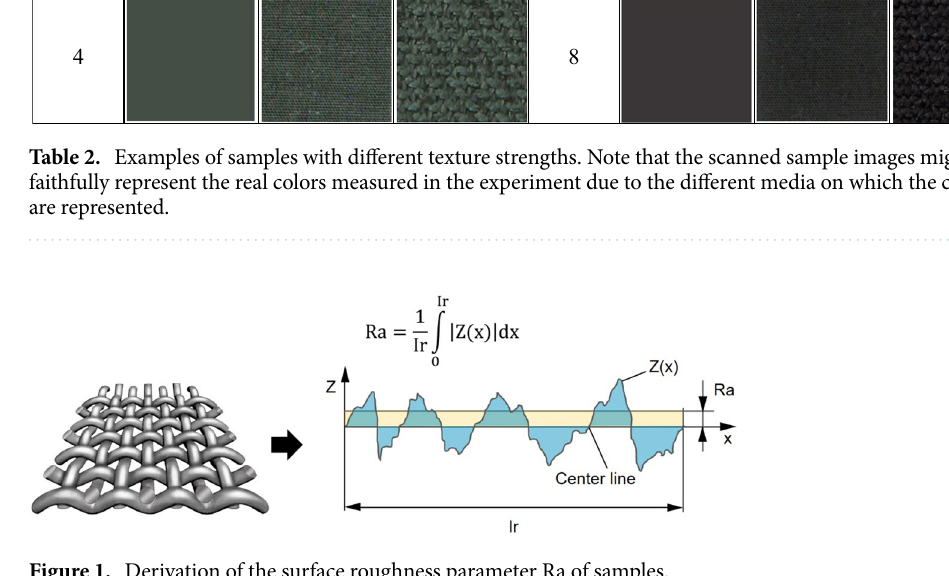
Figure 1. Derivation of the surface roughness parameter Ra of